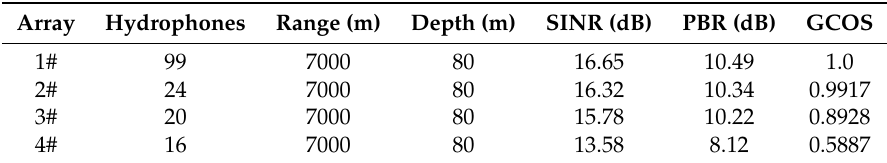
Table 2. Comparison among small and large arrays for matched field processing based on least squares (LSMFP).